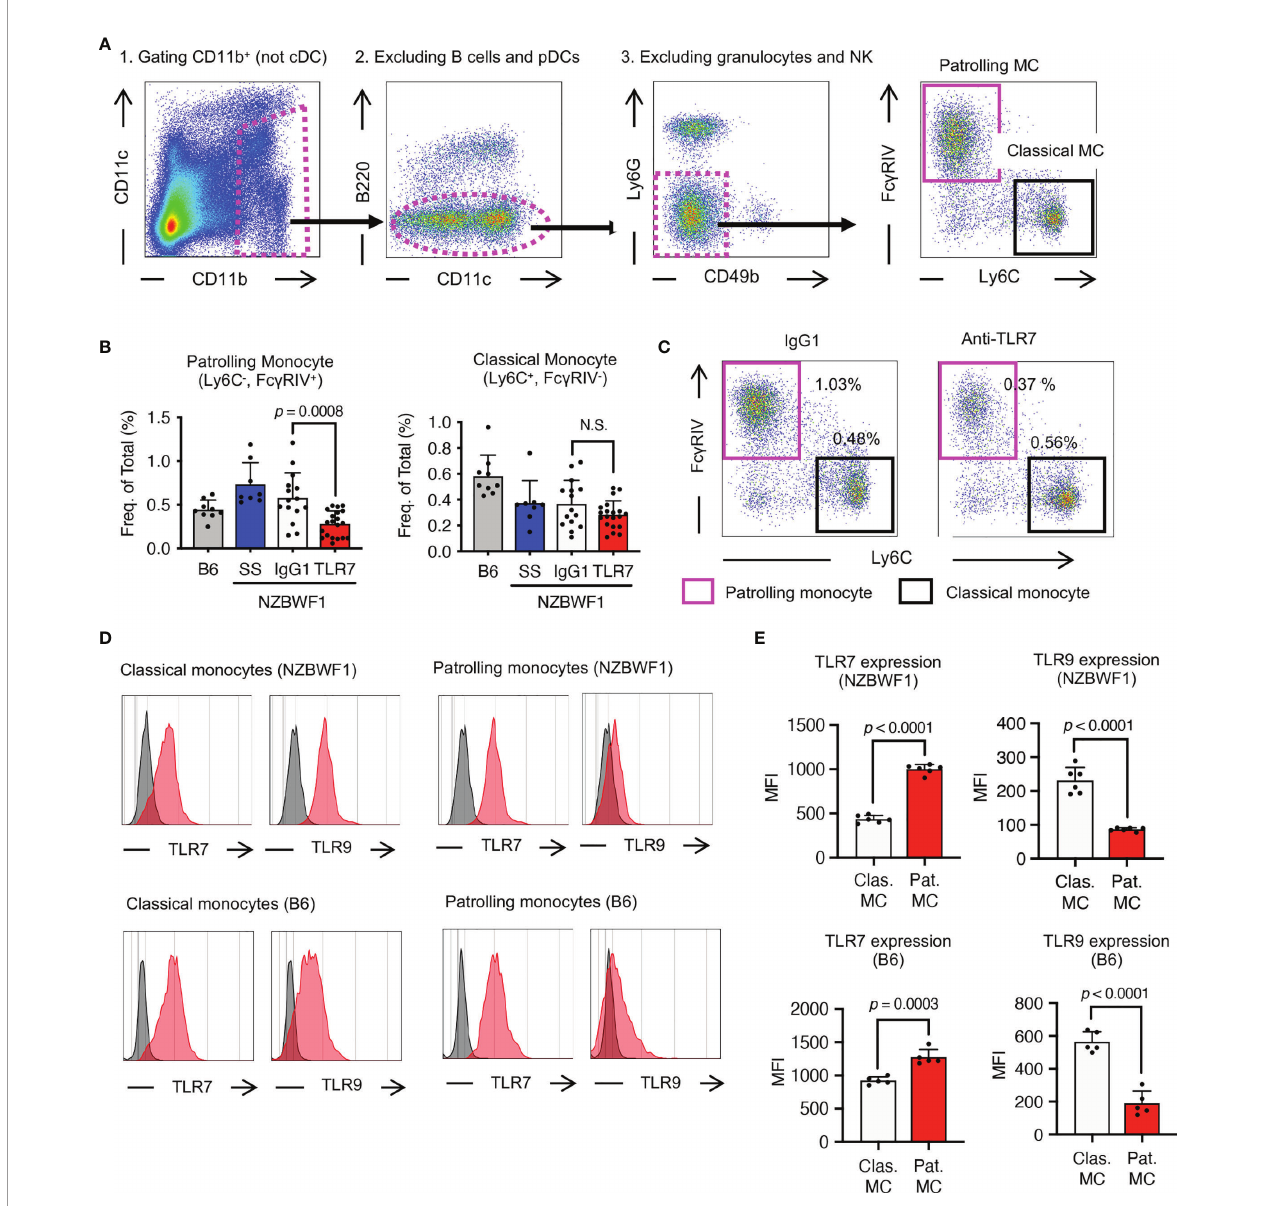
FIGURE 4 | Patrolling monocytes TLR7-dependently increased in NZBWF1 mice. (A) Gating strategy and markers for fl ow cytometry of monocyte subsets. Cells in magenta dotted gates were assessed using drill-down analyses. (B, C) NZBWF1 mice were administered saline, IgG1 or the anti-TLR7 mAb from age 12-16 to 35- 40 weeks and compared with age-matched B6 mice (B) Ratios of monocyte subsets in spleens: B6 ( n ≥ 5), saline ( n ≥ 6), control IgG1 ( n ≥ 15), and anti-TLR7 ( n ≥ 18). (C) Representative dot plots show monocyte subsets in NZBWF1 mice administered IgG1 or anti-TLR7 mAb. (D) Red histograms show expression of TLR7 and TLR9 in classical and patrolling monocytes in spleens of 14-week-old NZBWF1 mice detected by membrane permeabilized staining. Gray histograms, staining with isotype-matched control antibodies. (E) Statistical analysis of mean fl uorescence intensity (MFI) of TLR7 and TLR9 staining in monocyte subsets ( n = 6). Data were statistically analyzed by ordinary one-way ANOVA with Tukey ’ s multiple comparison tests (B) or Student ’ s t-test (E) , and p -values are shown. Data are shown as individual points and as means ± SD for each experimental group (B, E)